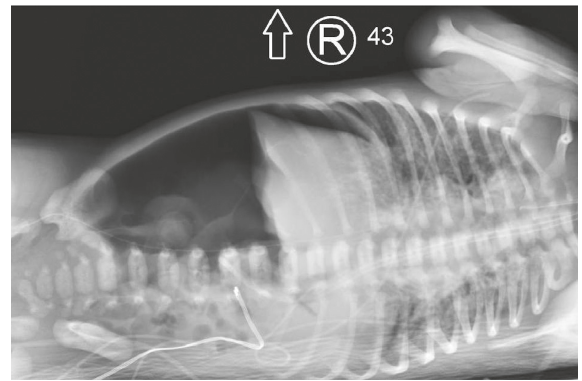
Figure 3: Lateral decubitus radiograph depicting a large